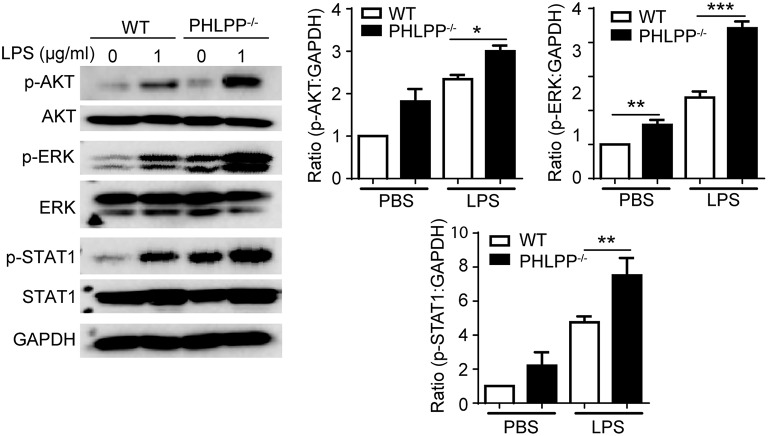
PHLPP deficiency elevates the activities of AKT, ERK and STAT1. Immunoblotting of purified neutrophils from bone marrow stimulated with LPS (1 μg/ml) or PBS as control overnight. Right panels are blot quanifications (n = 3) *p < 0.05, **p < 0.01, and ***p < 0.001.